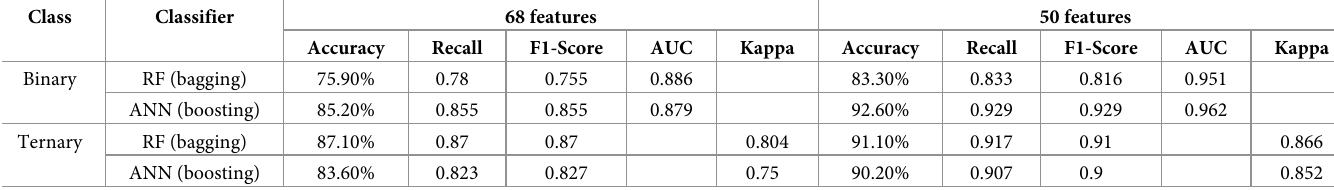
Table 5. Comparison of the performance of the models based on 68 features and 50